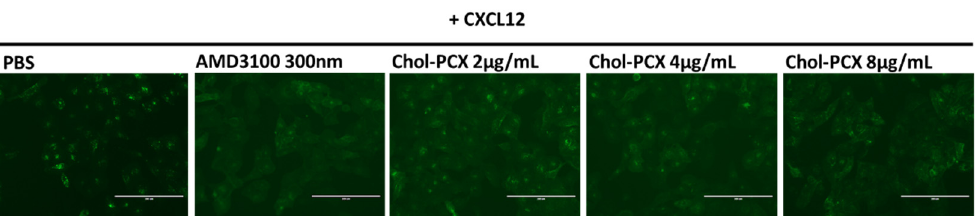
Figure 6. CXCR4 redistribution. U2OS-overexpressing EGFP-CXCR4 cells were treated with Chol- PCX for 30 min before incubation with 10 nM CXCL12. AMD3100 (300 nM) was used as the positive control (scale bar = 200 μ m).